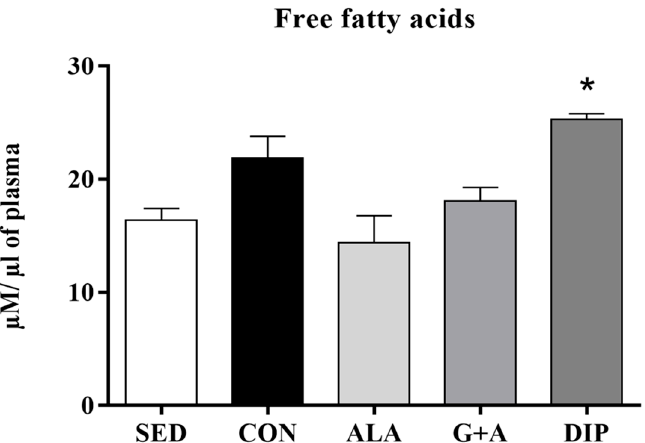
Figure 3. Plasma free fatty acids of rats submitted to resistance training and supplementation with L -glutamine and L -alanine. SED: sedentary group, CON: trained group, ALA: trained and supplemented with alanine, G + A: trained and supplemented with glutamine and alanine in their free form, and DIP: trained and supplemented with L -alanyl- L -glutamine. * p < 0.05 vs. SED and ALA. Data are presented as mean ± SD.